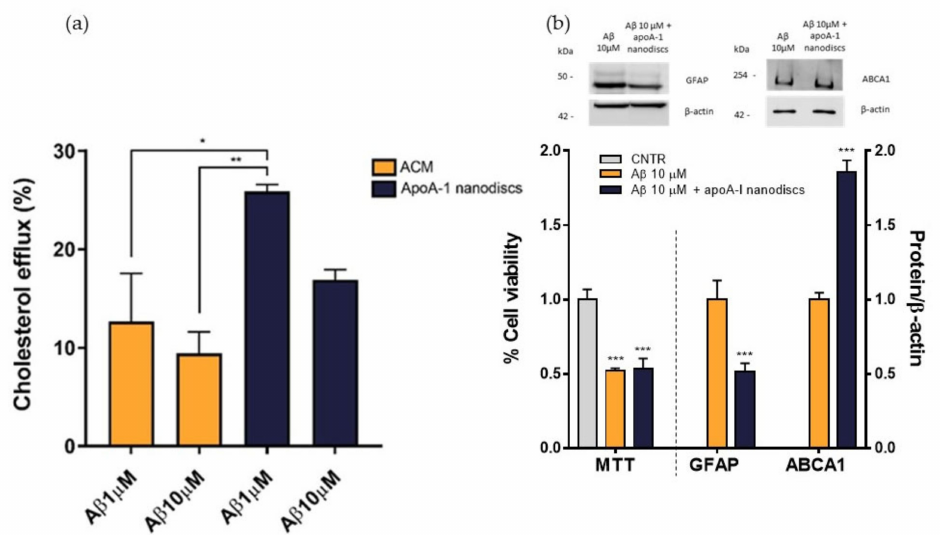
Figure 9. Evaluation of apoA-I nanodiscs efficacy in AD-like condition. ( a ) The cholesterol efflux was measured using the Cholesterol Efflux Assay kit. After treating the cells with A β 1-42 oligomers (1 µ M or 10 µ M) for 24 h, two different cholesterol acceptors, ACM or apoA-I nanodiscs (40 µ g/mL), were added. The fluorescence of supernatant and cell lysates was measured by spectrofluorometer. ( b ) Detection of cell viability, GFAP, and ABCA1 levels to confirm the apoA-I efficacy in restoring some cellular processes related to AD that were compromised by A β oligomers; * p <0.05; ** p ≤ 0.01; *** p ≤ 0.001 (one-way